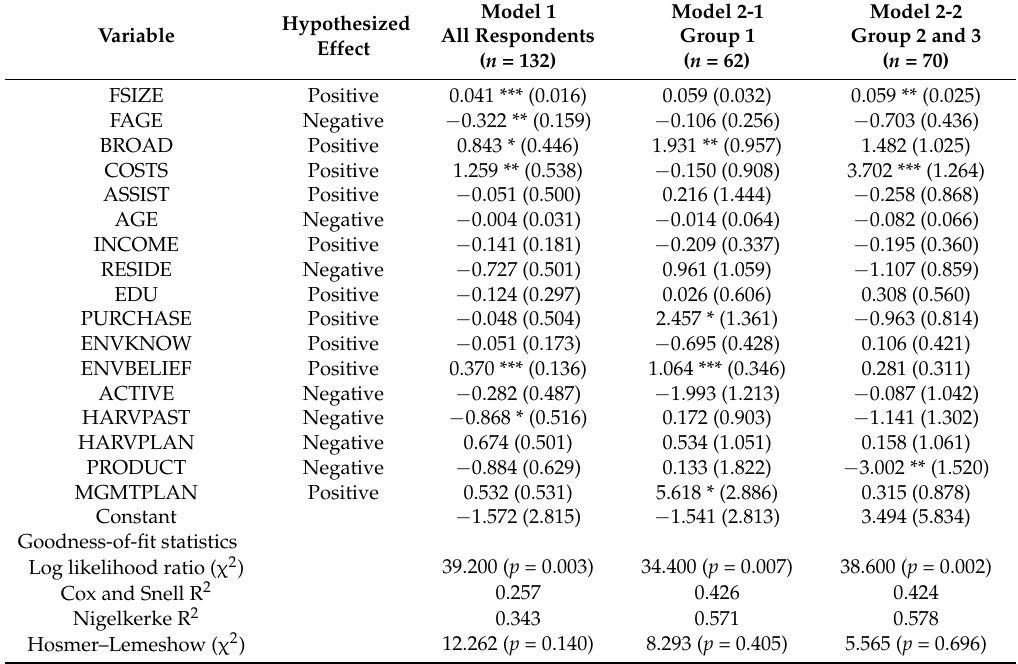
Table 5. Regression coefficients and standard errors (in parentheses) of variables estimated in all three models. Dependent variable is whether a forest owner is willing to invest in an FCO project.